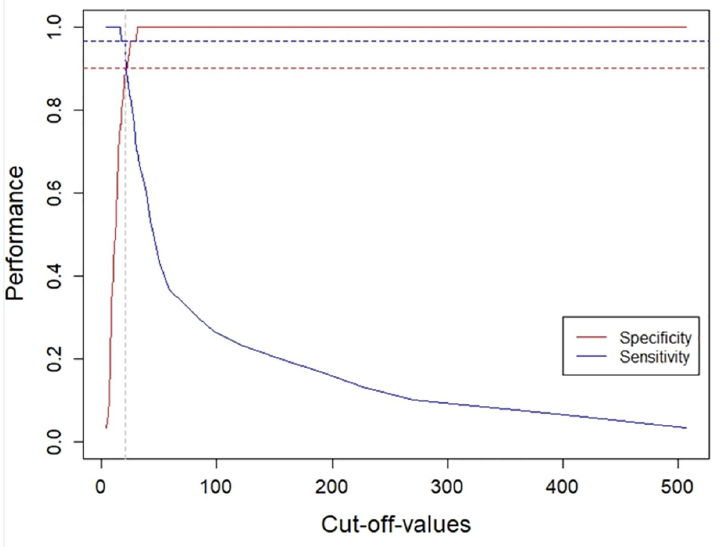
Fig 4. Sensitivity and specificity of the HpAfr-ELISA assay in the training set. This plot indicates that the HpAfr- ELISA assay had a sensitivity of 96.7% (dashed blue line) and a specificity of 90.0% (dashed red line) when considering its best cut-off-value (dashed black line) defined at the Youden index of the dataset (the point with the maximum specificity + sensitivity).